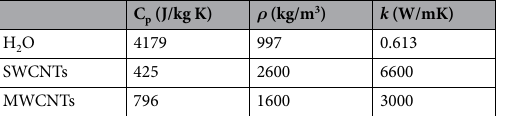
Table 1. Characteristics of H 2 O and both types of CNTs i . e ., SWCNTs, and